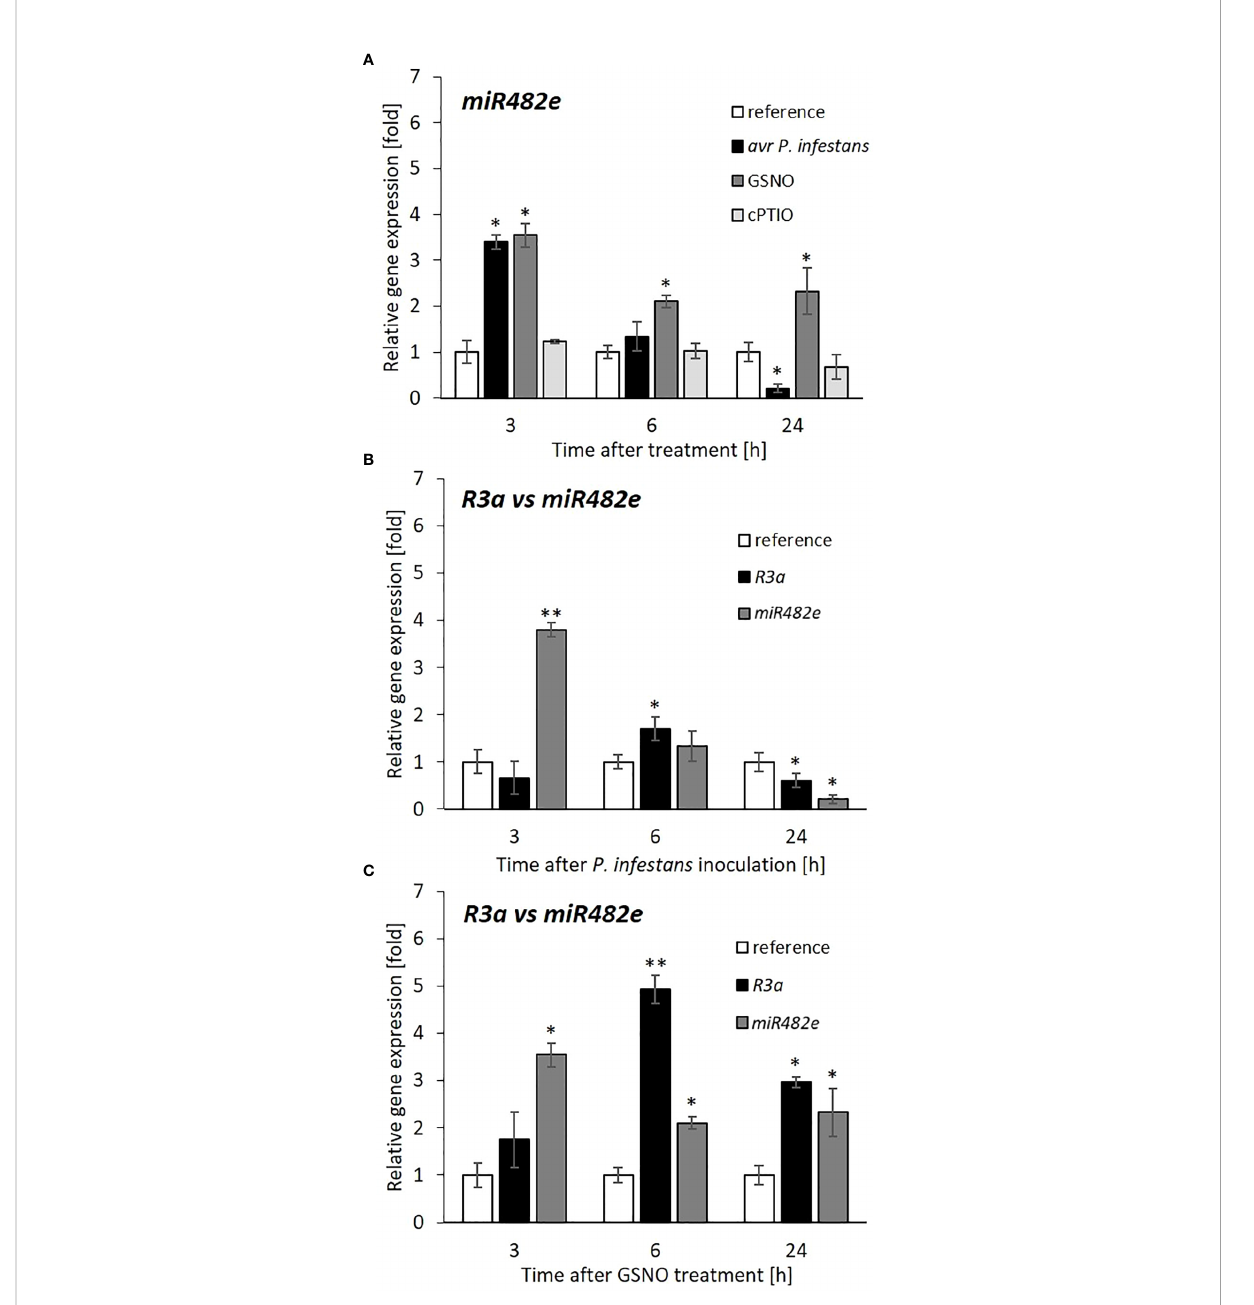
FIGURE 6 Expression pro fi le of miR482e and its target, R3a gene after avr P . infestans or GSNO treatment. RT-qPCR analysis of the miR482e (A) , relative miR482e versus R3a genes expression after pathogen (B) , or GSNO (C) treatment, respectively. All data in (B) and (C) regarding R3a and miR482e transcript levels referred to the separate reference presented as 1 for R3a and miR482e , respectively. Values represent the means of data ± SD of at least three independent experiments. Asterisks indicate values that differ signi fi cantly from water-treated (reference) potato leaves at a <0.05 ( ∗ ) and a <0.01 ( ∗∗